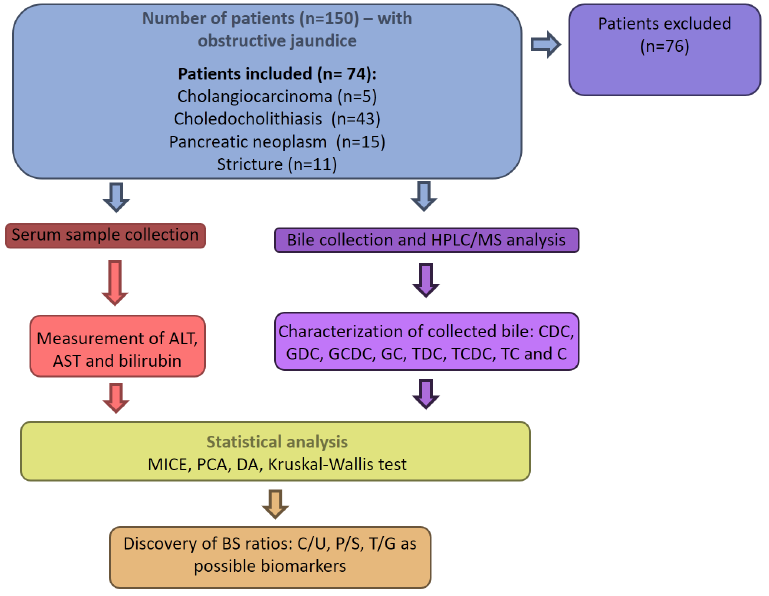
Figure 8. Flowchart from sample collection to analysis and statistical